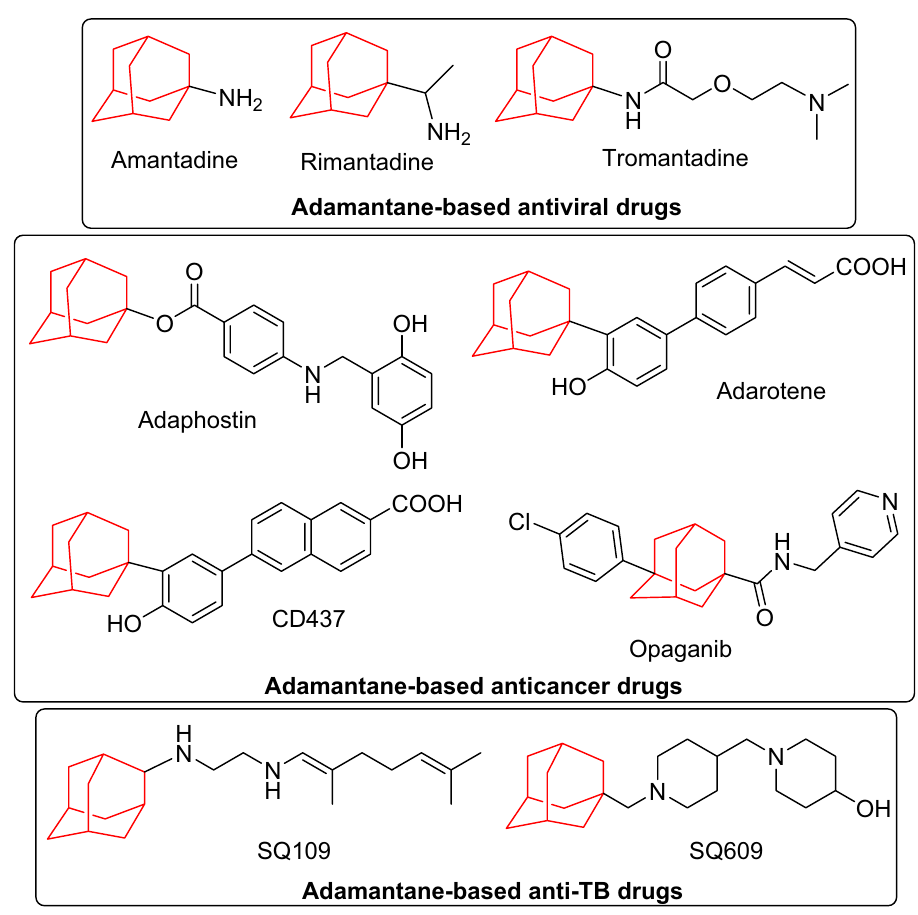
Figure 1. Adamantane-based chemotherapeutic drugs and drug